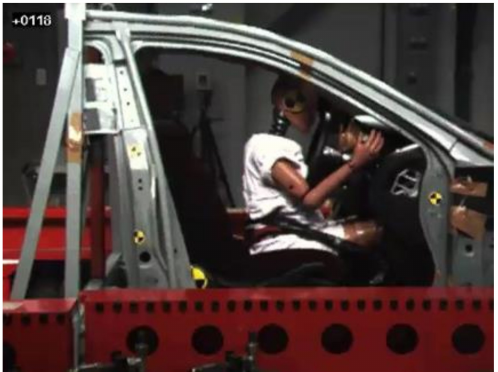
Figure 2. Instant at which the chest of the dummy made contact with the center of the steering wheel in test 1.